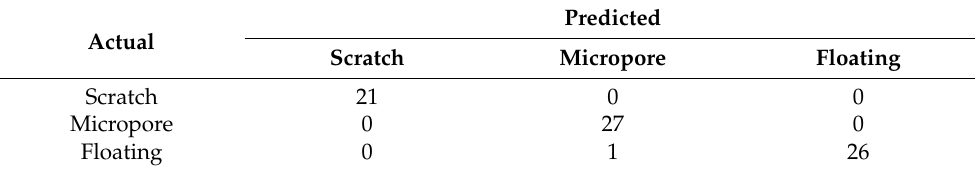
Table 2. Confusion matrix of recognition results.